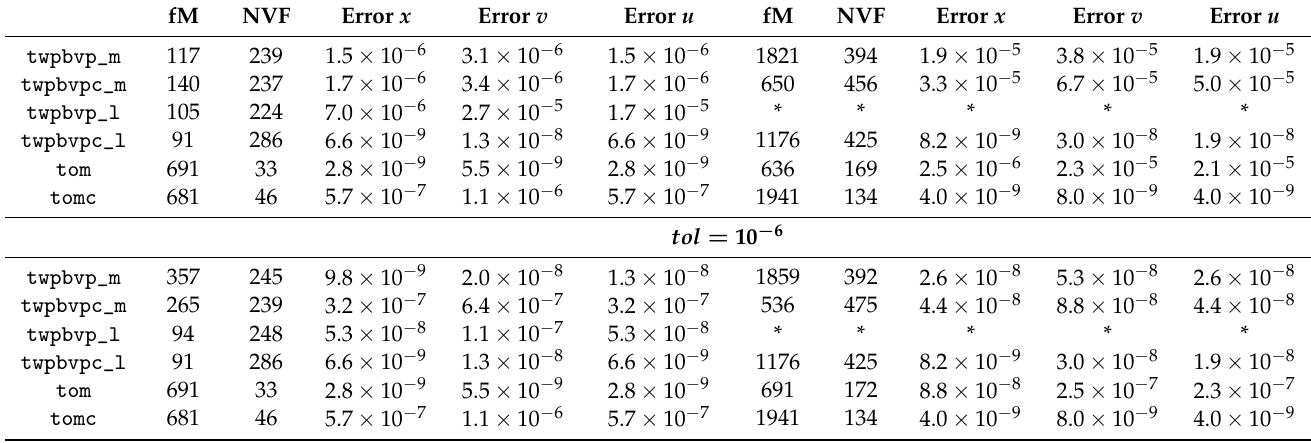
Table 7. Hypersensitive problem solved with an initial mesh with 11 equidistant points: final mesh (fM), total number of vectorized function evaluation (NVF) and mixed errors for x , v , u